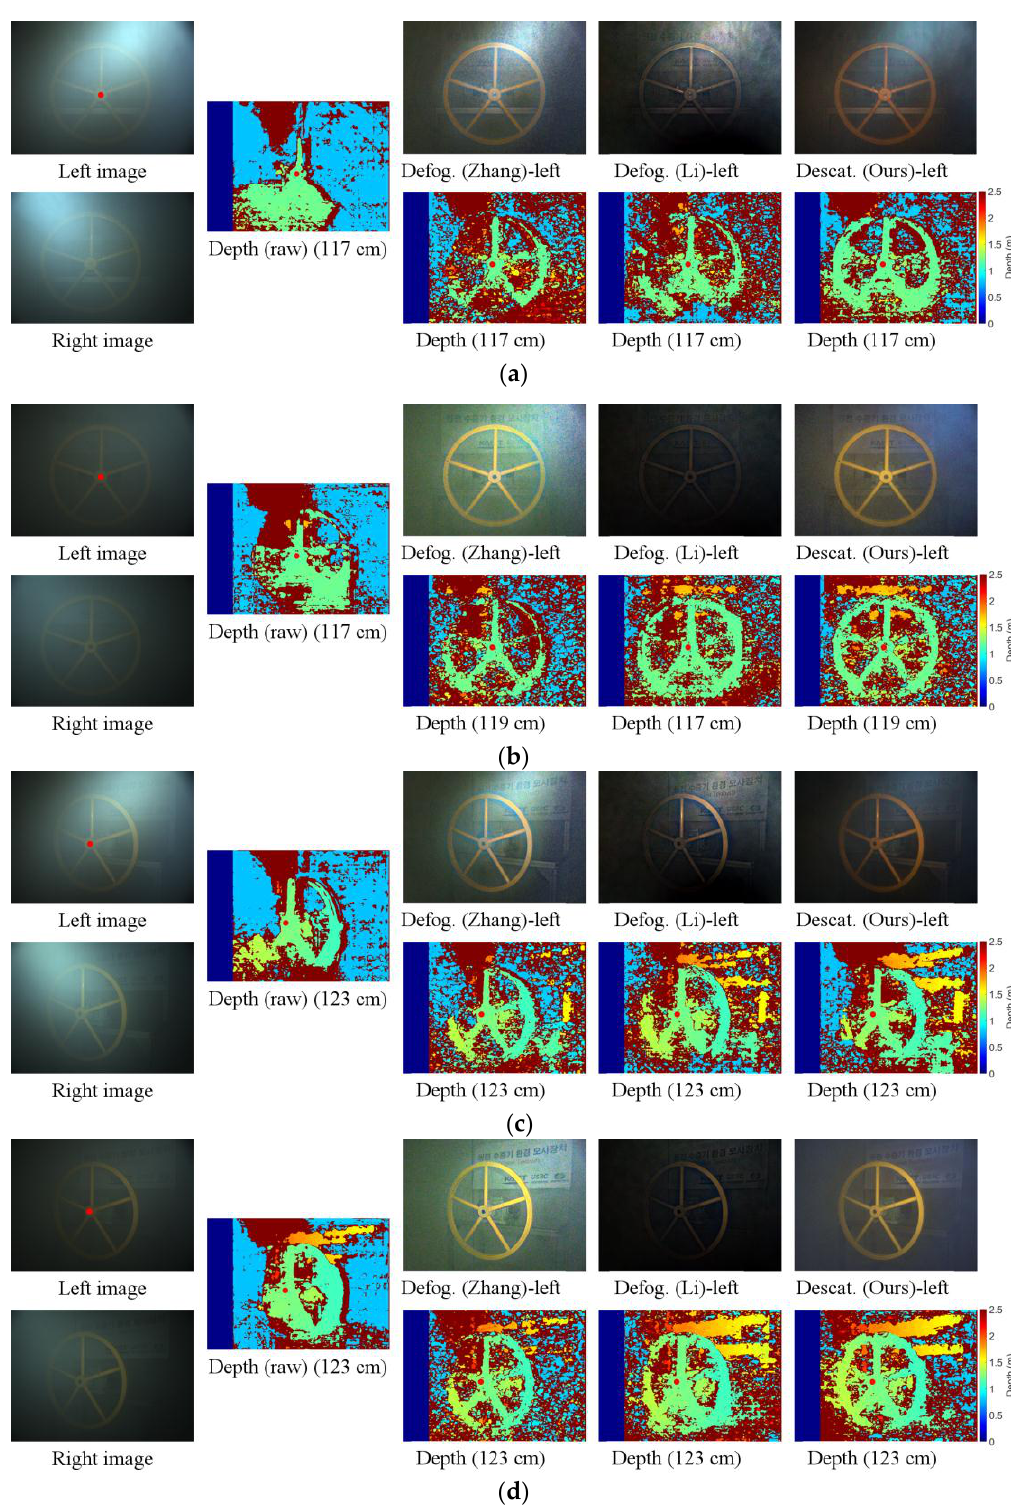
Figure 9. Experimental results; the stereo method is SGM: ( a ) Lighting 2— V = 1.71 m and polarization angle of 45°; ( b ) Same as ( a ) with polarization angle of 90°; ( c ) Lighting 2— V = 2.39m and polarization angle of 45°; ( d ) Same as ( c ) with polarization angle of 90°;. The first column is corrupted images; the second is disparity from input images; the third to last columns are the defogged (or descattered) images and disparity maps obatined using methods in [35,36] and the proposed method, respectively. The number under the every depth map is the measured depth at the red dot.